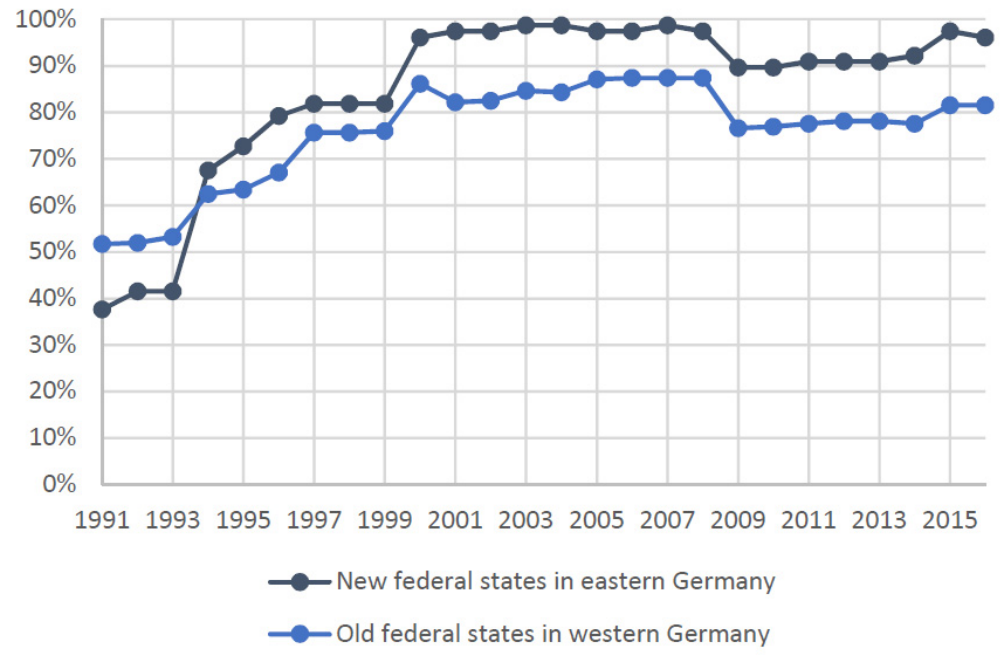
Figure 6. Deployment of programmes between 1991 and 2016 in the new federal states in eastern Germany and the old federal states in western Germany (relative figures). Source: authors’ compilation (Department of Geography Giessen, Institute for Labour and the Economy Bremen).